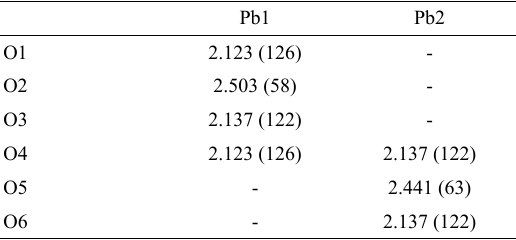
Table 2. Average Pb–O bond length (Å) and overlap population (m|e|) of